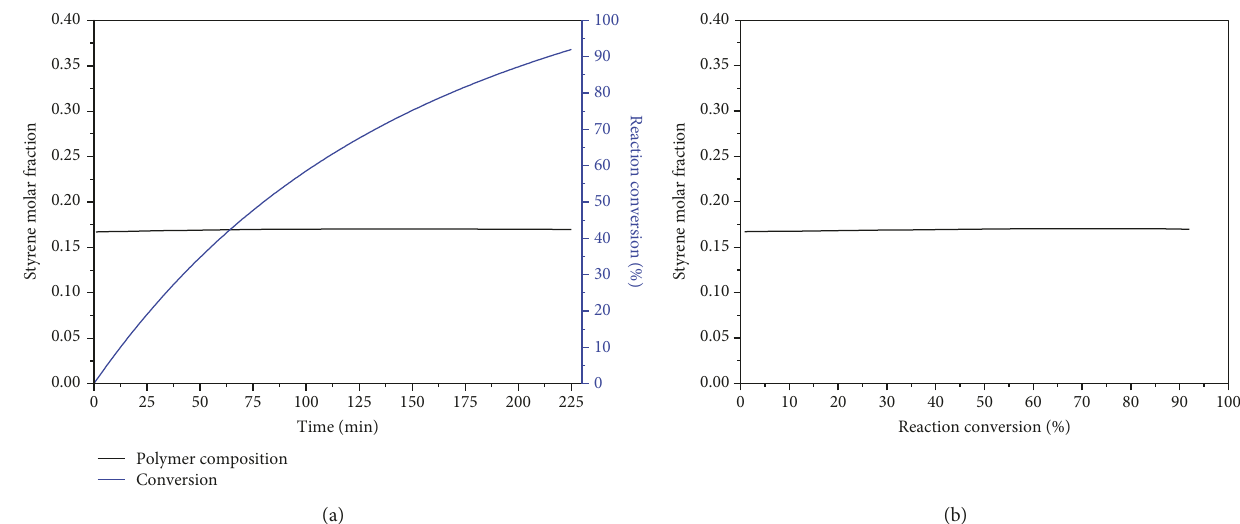
Figure 1: Conversion and copolymer composition pro fi les. I = 0 17 mol, M